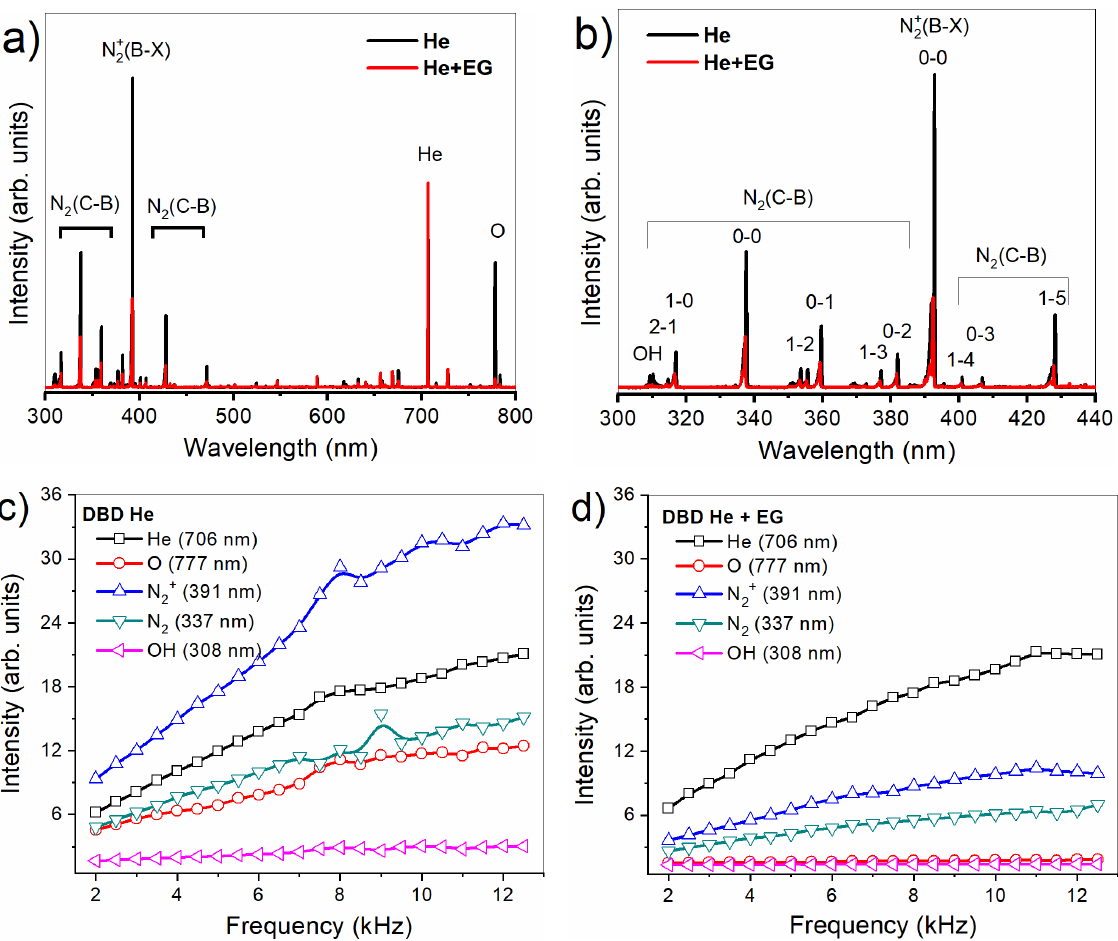
Figure 5. Space-integrated OES obtained results: ( a ) wide emission spectra recorded for 2 kHz applied voltage frequency; ( b ) nitrogen vibrational emitted bands, N 2 ( C 3 ∏ u → B 3 ∏ g ) and N + ( B 2 ∑ → X 2 ∑ + ) , with involved transitions; intensity variations of the most representative plasma species with frequency, recorded for DBD plasma operated in ( c ) He and ( d ) He with ethylene glycol vapors. (EG)